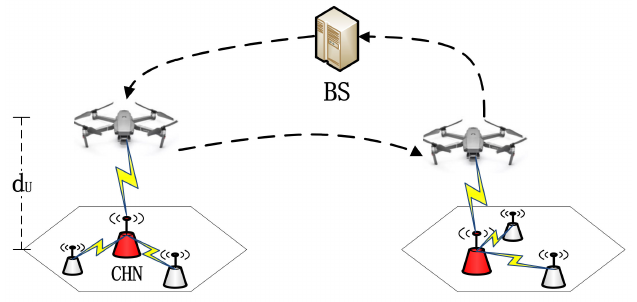
Figure 3. The detailed data collection process of